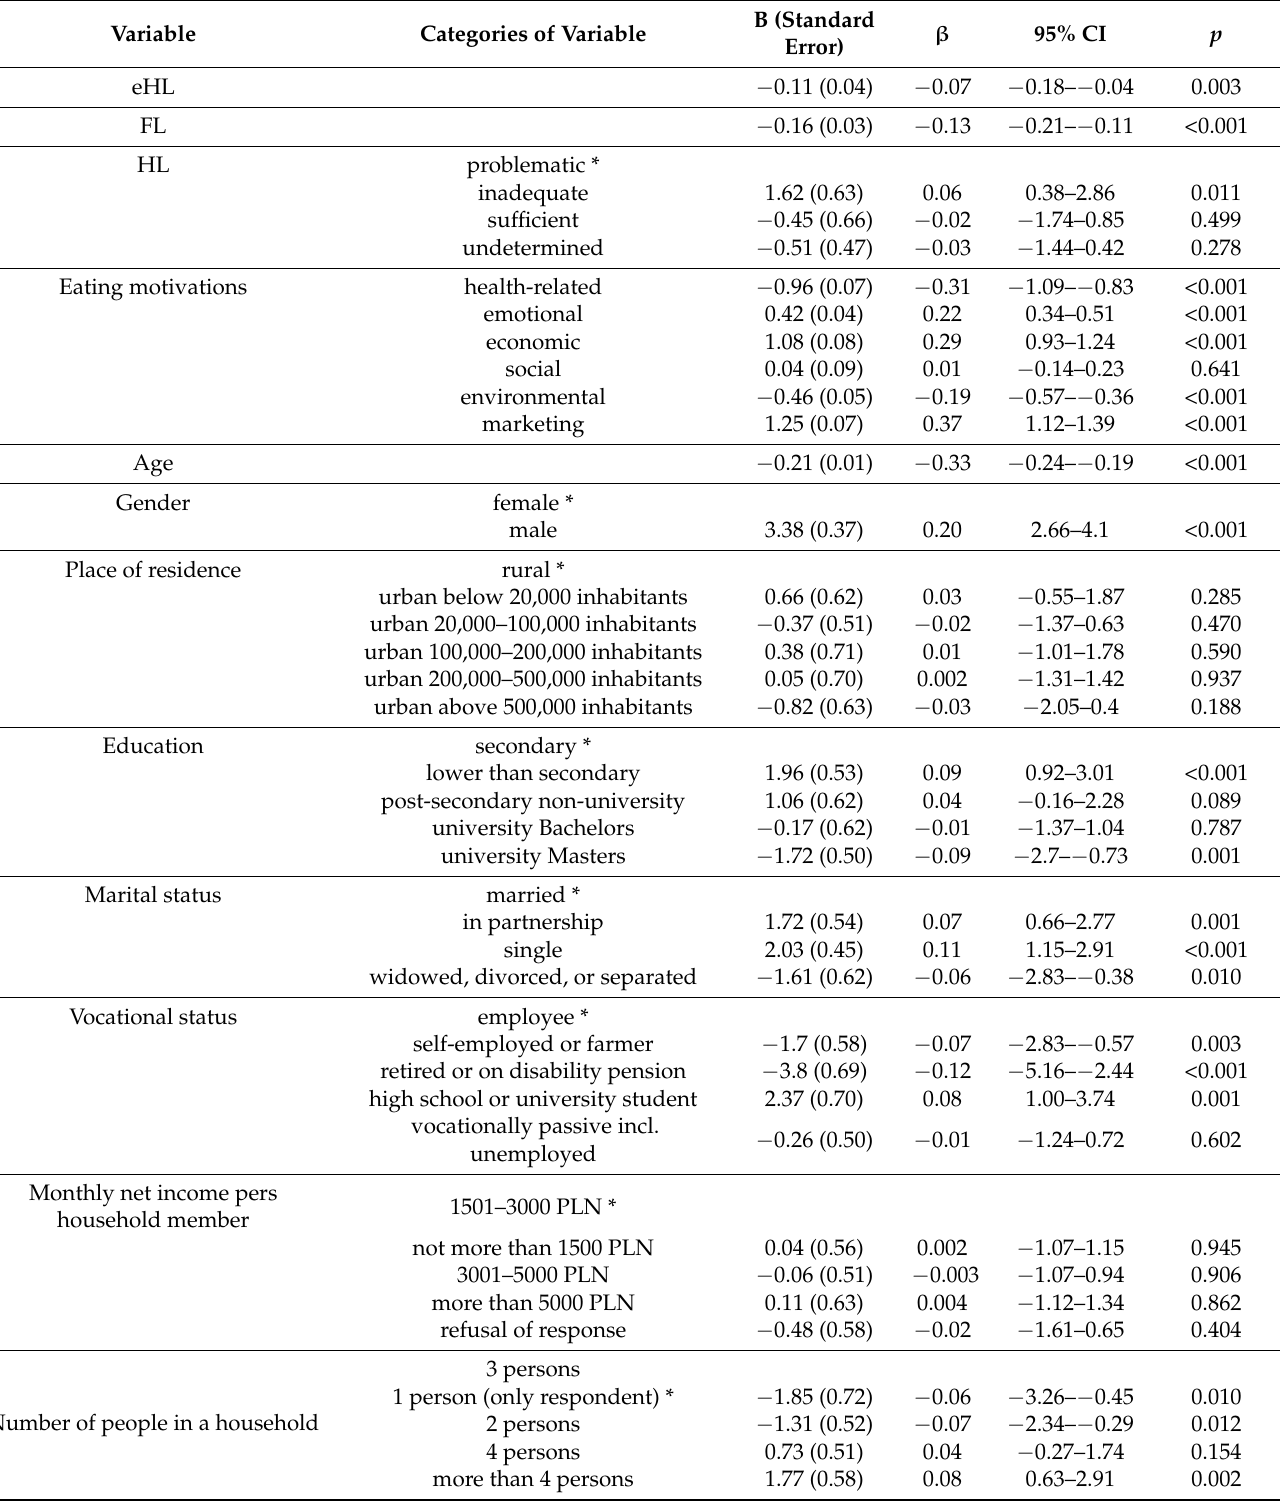
Table 3. Univariate linear regression of the Index of Unhealthy Food Choices (IUFC) as the dependent